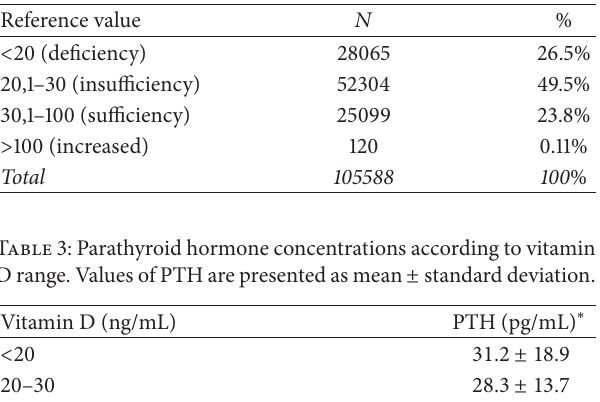
Table 2: Percentage of serum 25(OH)D results according to refer- ence values.